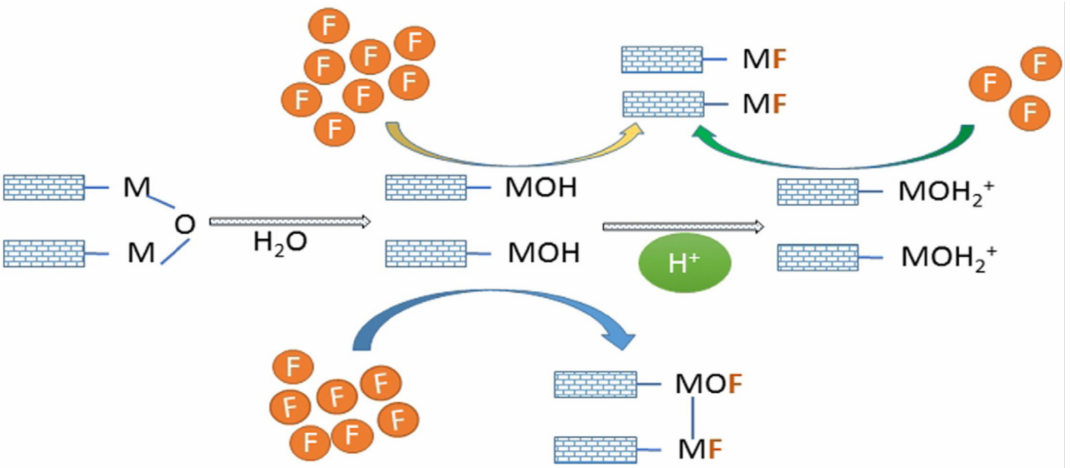
Figure 3. A simplified diagram of the ligand exchange mechanism of fluoride adsorption on hydrous metal oxides. Adopted and slightly modified with permission from Vinati et al. [100]. Copyright 2015,